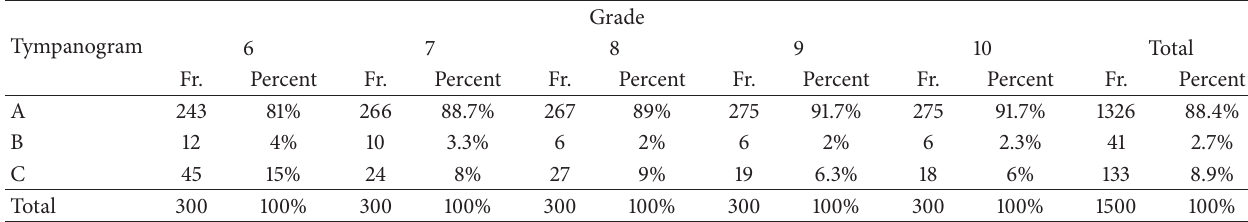
Table 2: Frequency distribution of types of tympanogram based on school grade. Tympanogram